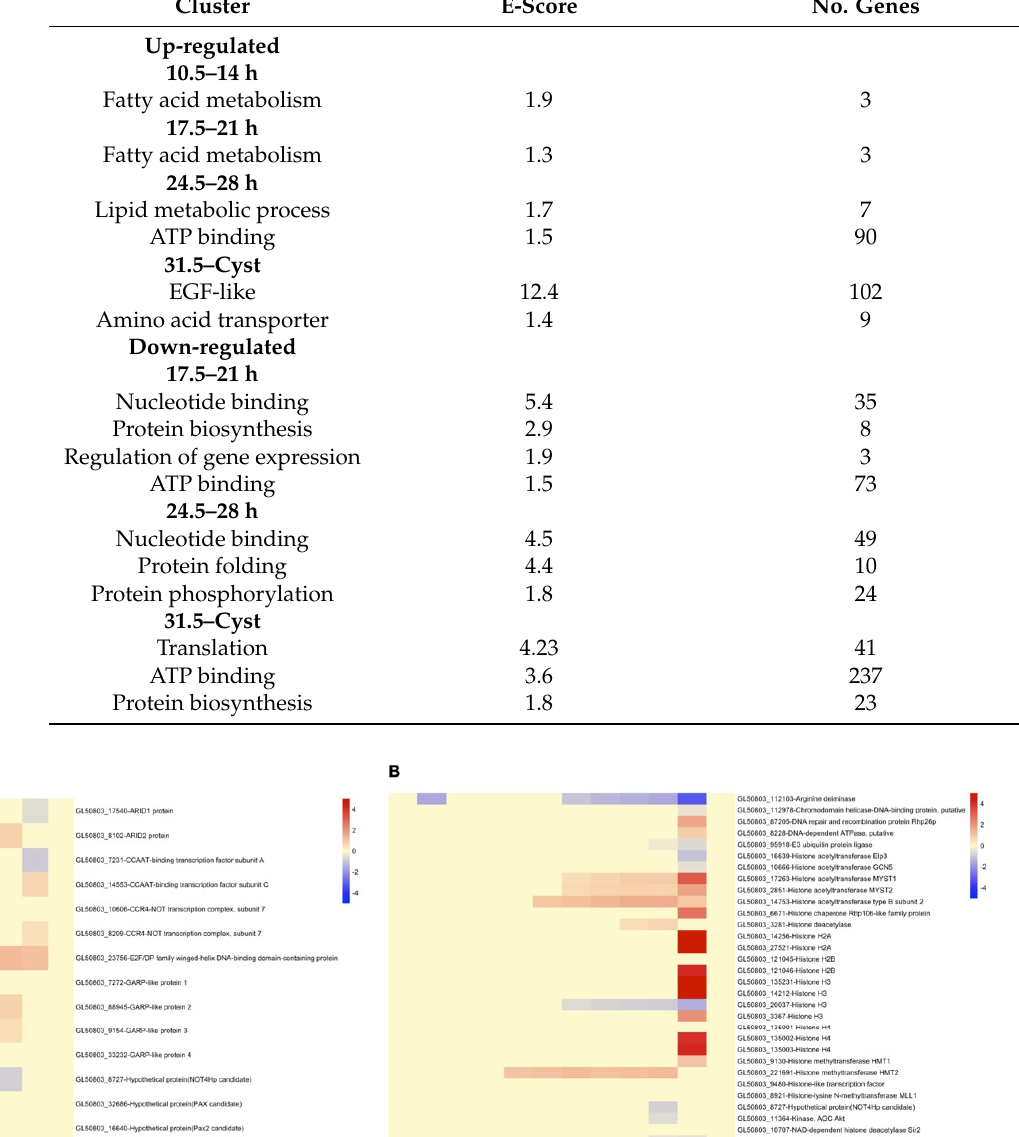
Table 2. GO term analyses of DEGs during encystation and excystation of Giardia .